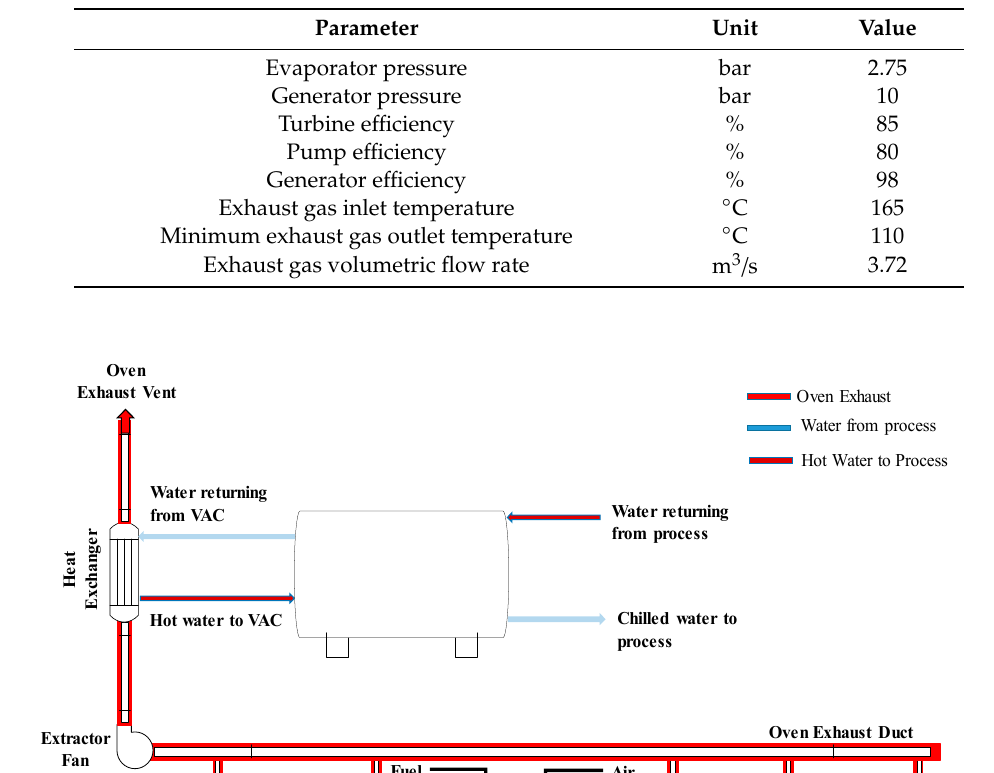
Table 4. List of input parameters of the Vapour Absorption Refrigeration (VAR) system in the Aspen Plus model.